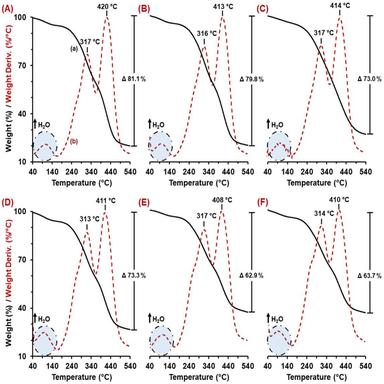
Thermal analysis of Bent-AA-PE1 (A), Bent-AA-PE2 (B), Bent-AA-PE3 (C), Bent-AA-PE4 (D), Bent-AA-PE5 (E) and Bent-AA-PE6 (F). TGA (a) and DTG (b).